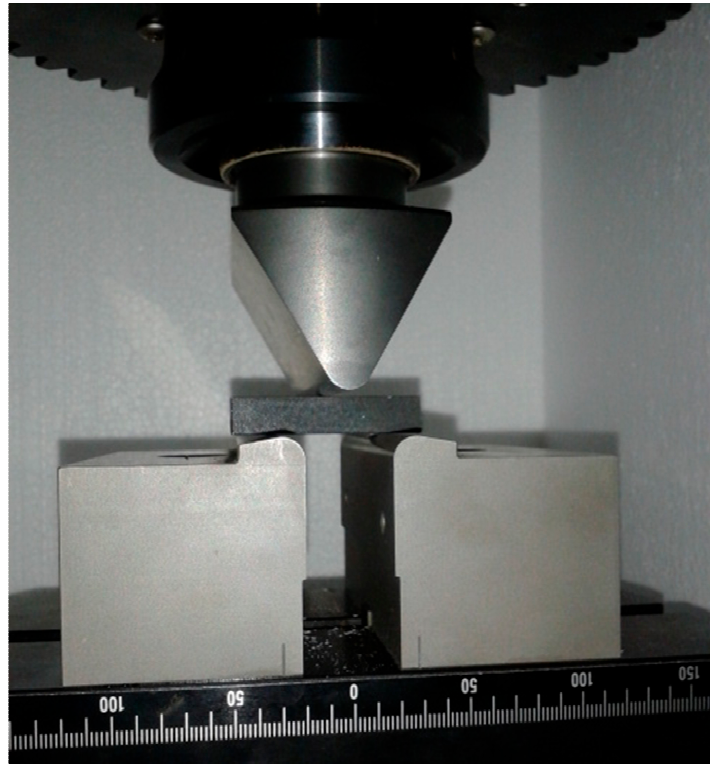
Figure 1. Specimen position under three-point bending loading.